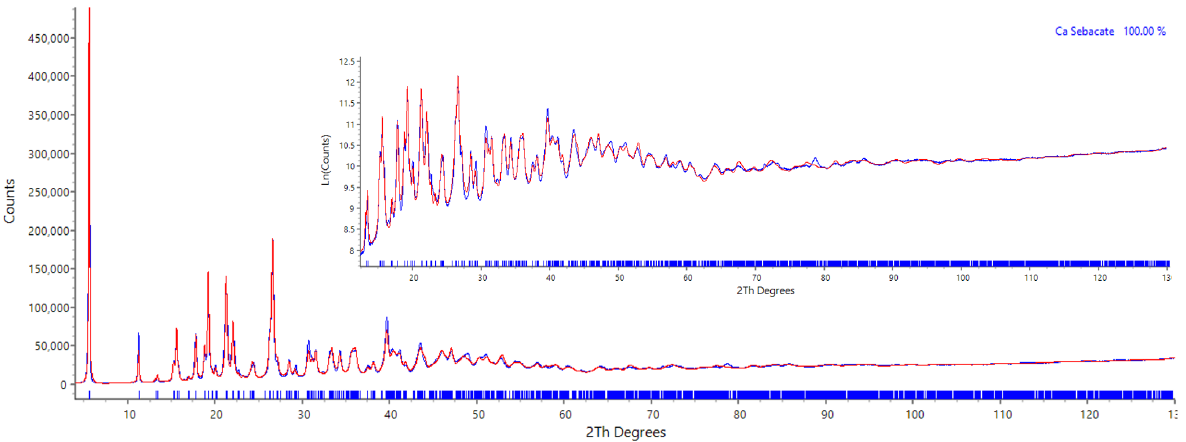
Figure 3. Rietveld structural refinement (red) of calcium sebacate experimental XRPD data